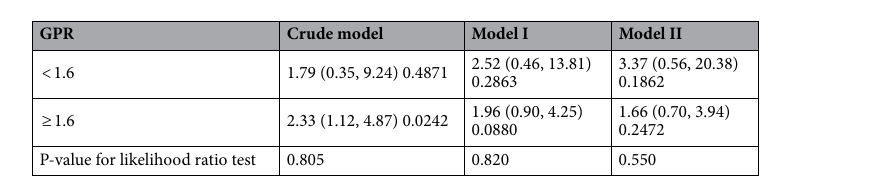
Figure 2. Multivariate adjusted smooth curve-fitting for association between GPR and 30-day mortality. GPR glucose to potassium ratio. ( a ) Crude model: not adjusted. ( b ) Mode I: adjusted for age and gender. ( c ) Mode II: adjusted for age, gender, department, serum sodium, serum albumin, serum-magnesium tertiles, hypertension, heart failure, chronic renal failure, and pneumonia. The red line represents the best-fit line, and the blue lines are 95% confidence intervals. The potential demarcation points are 1.6 according to the smoothing spline plots.